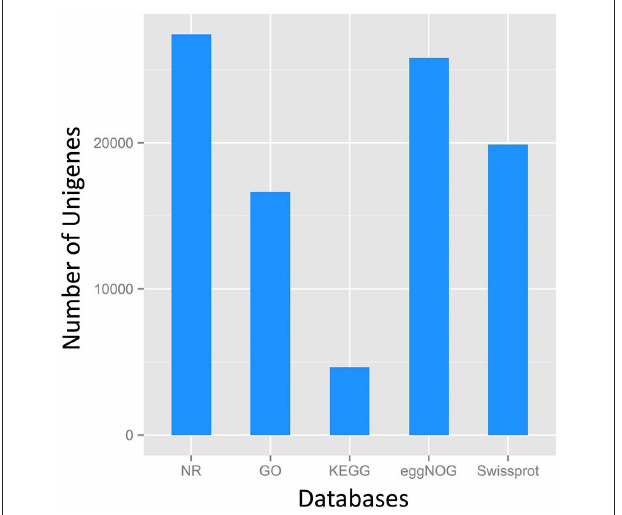
FIGURE 1 | Number distribution of annotation results of Unigenes in Nr, GO, KEGG, eggNOG, Swissport